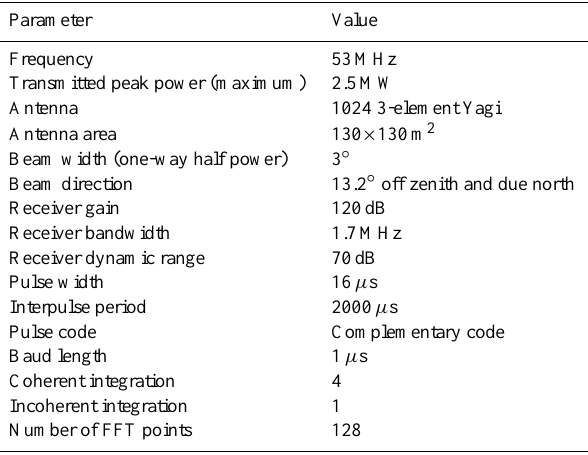
Table 1. The MST radar specifications and other important param- eters used for the FAI